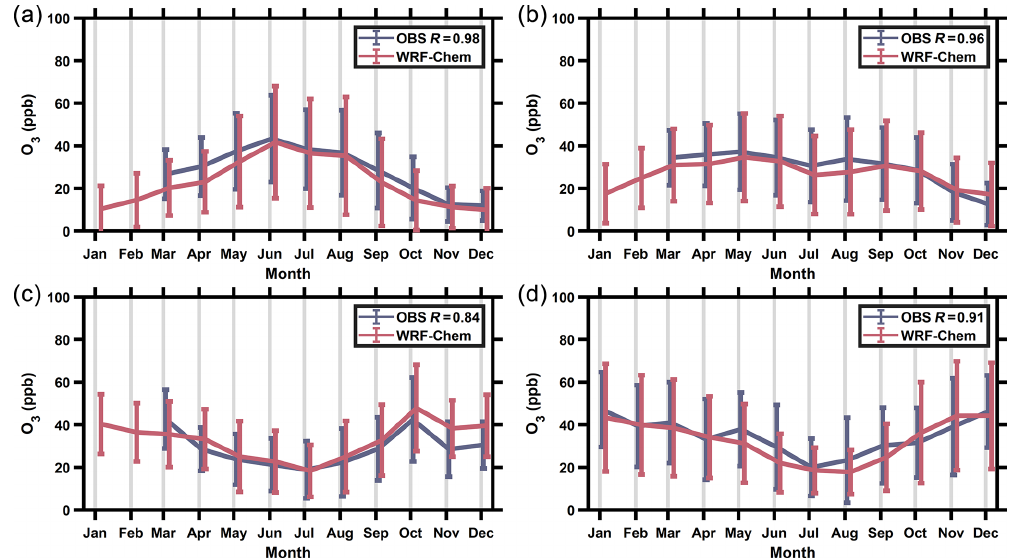
Figure 4. Observed and simulated monthly mean O 3 concentrations averaged for the North China Plain (NCP) (a) , Yangtze River Delta (YRD) (b) , Pearl River Delta (PRD) (c) , and India (d)